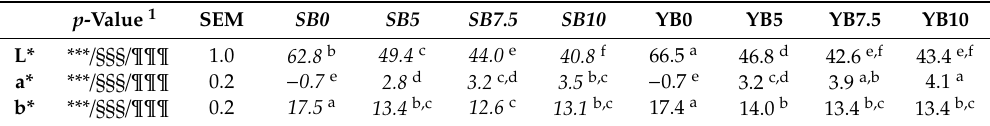
Table 5. Color coordinates L*a*b* values of the cooked bread samples. Data presented are the mean of three replicates. Data reported in italics were already published in Sanmartin et al., 2020 [39]. p -Value 1